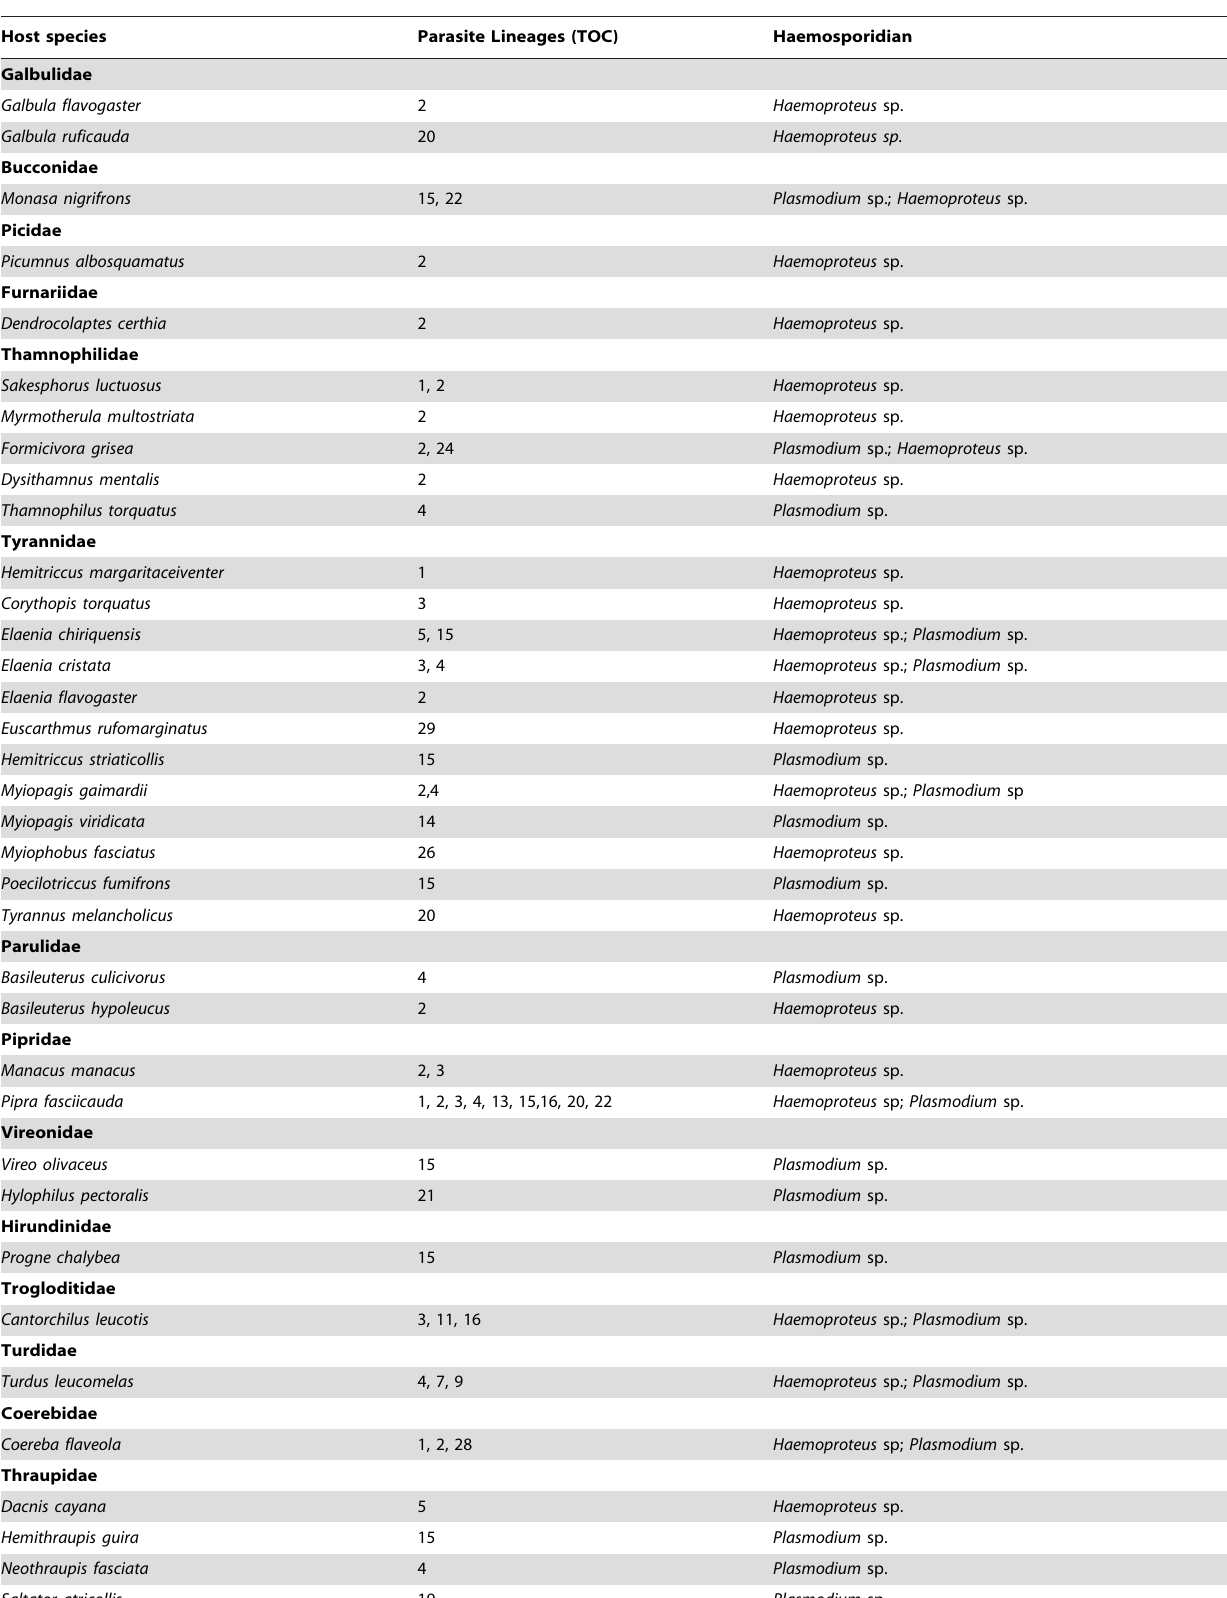
Table 4. Host species and parasite lineages in Tocantins areas/Brazil.